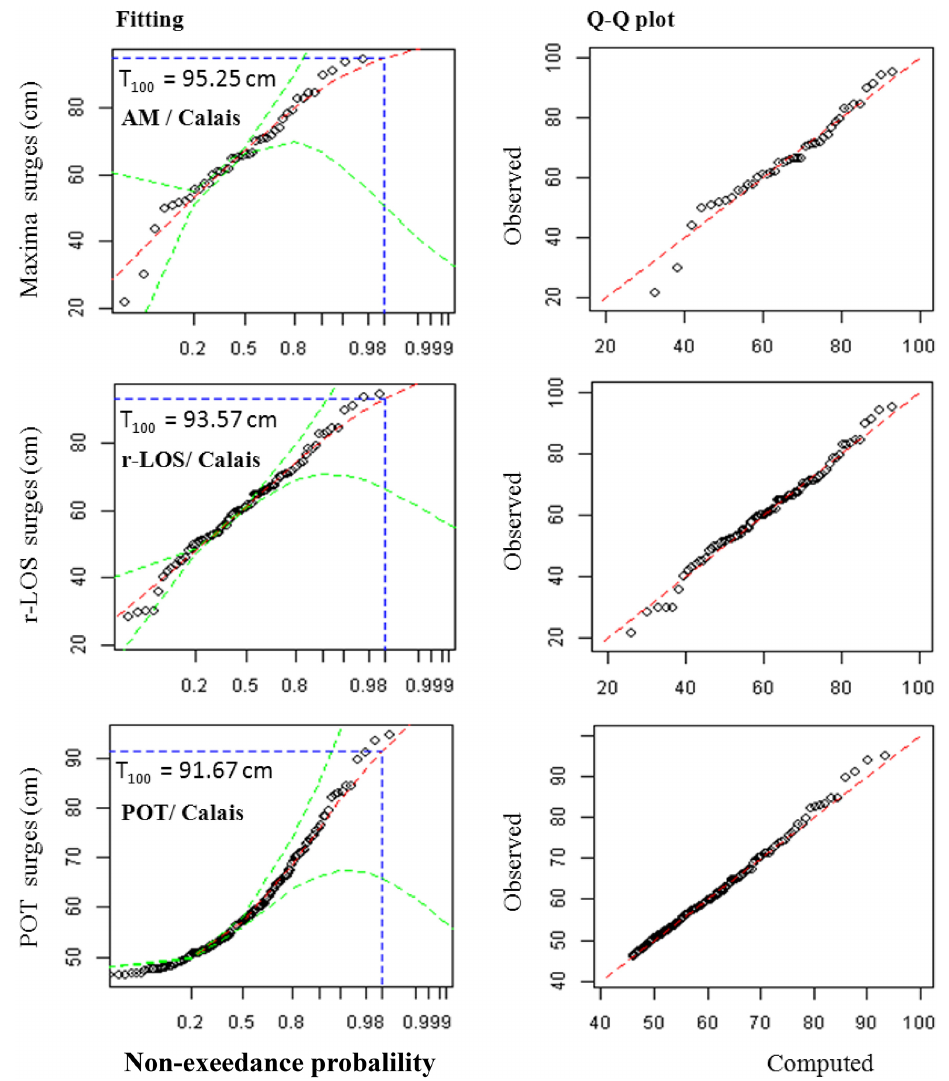
Figure 6. Visual inspection – example of a distribution fit (and Q–Q plot) for Calais station (without outlier) using AM (annual maxima), r -LOS ( r -largest order statistics) and POT (peaks-over-threshold) methods. The 95% lines correspond to confidence intervals. The T 100 is the 100-year return